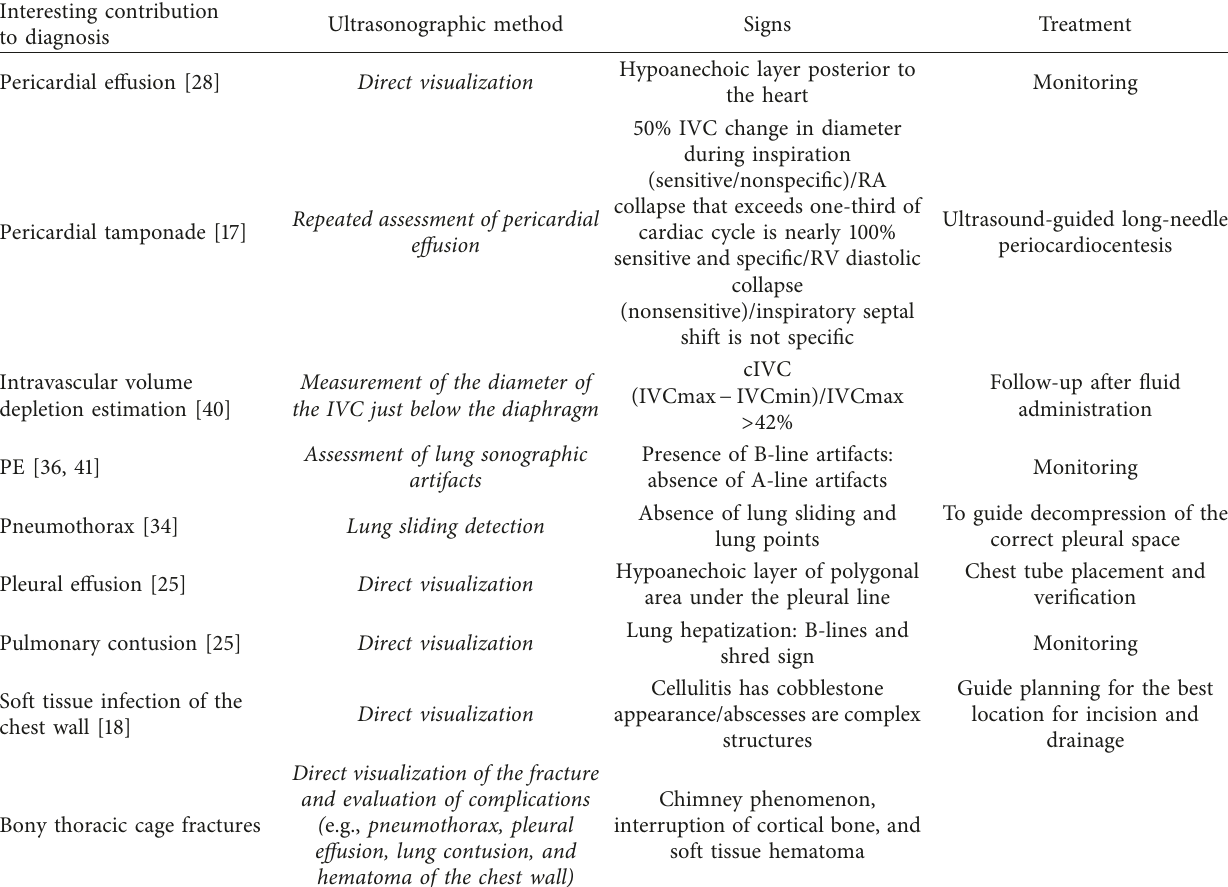
Table 2: Conditions for which the use of CU has been proposed in the scientific